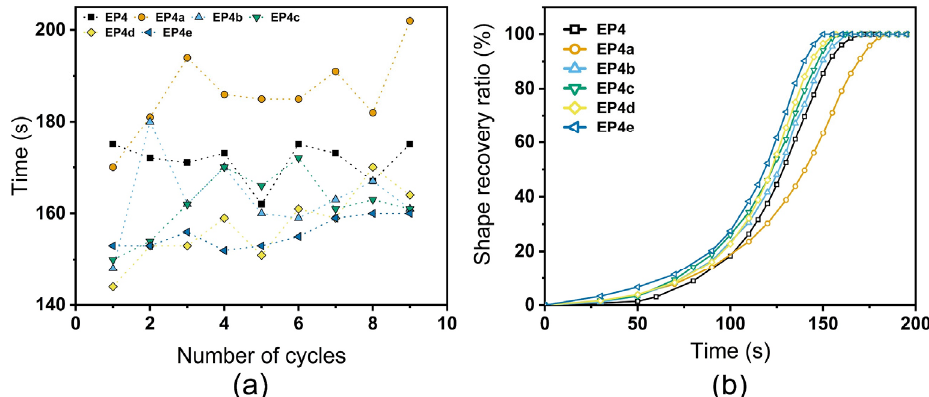
Figure 9. ( a ) Average recovery time during 9 times fold-unfold process. ( b ) Recovery ratio as the function of deployment time of ANCs incorporated SMEPNs (EP4, EP4a, EP4b, EP4c, EP4d, EP4e, respectively, correspond to 0.00, 0.02, 0.06, 0.20, 0.40, 0.60 wt.% ANCs incorporated in matrix with mole ratio of epoxy monomer to curing agent 𝜂 = 1.75).